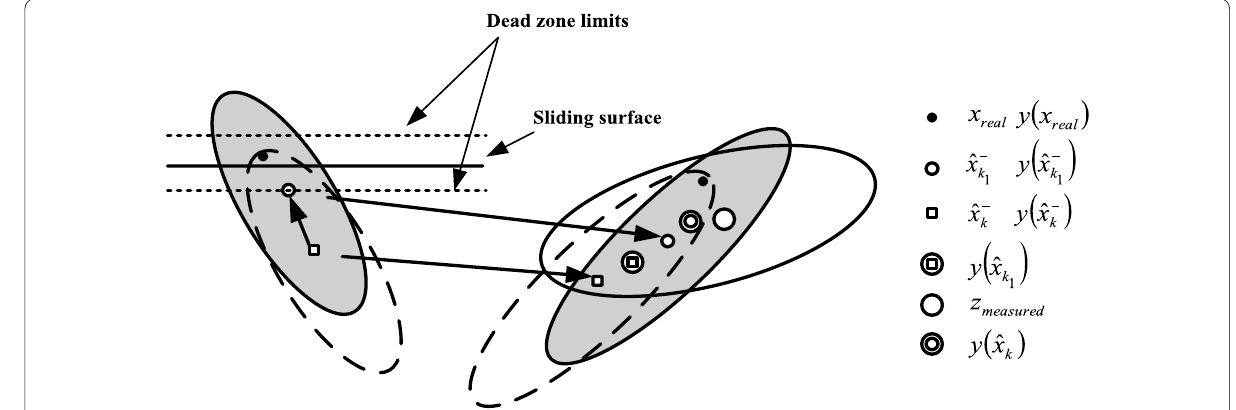
Figure 4 Sliding mode update